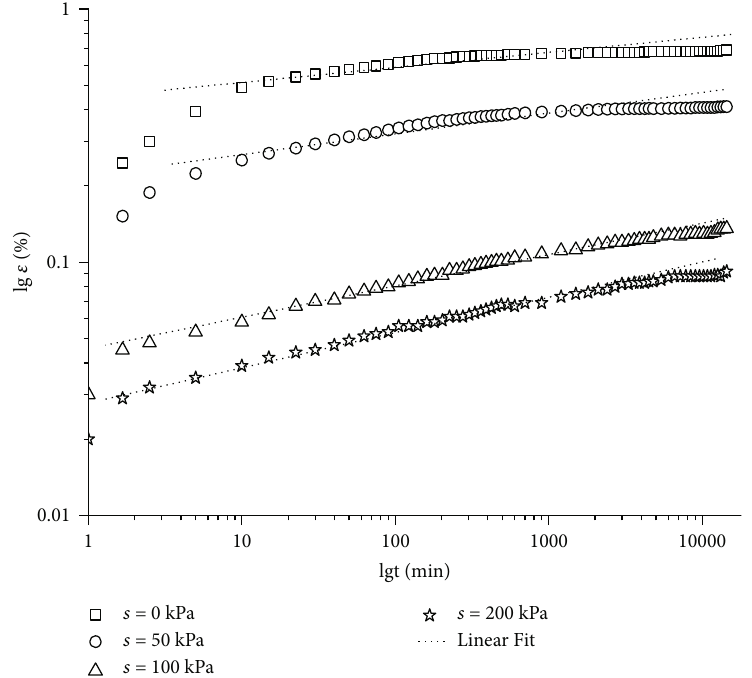
Figure 2: The curve lg ε − lg t of di ff erent matric suctions when p = 50 kPa .